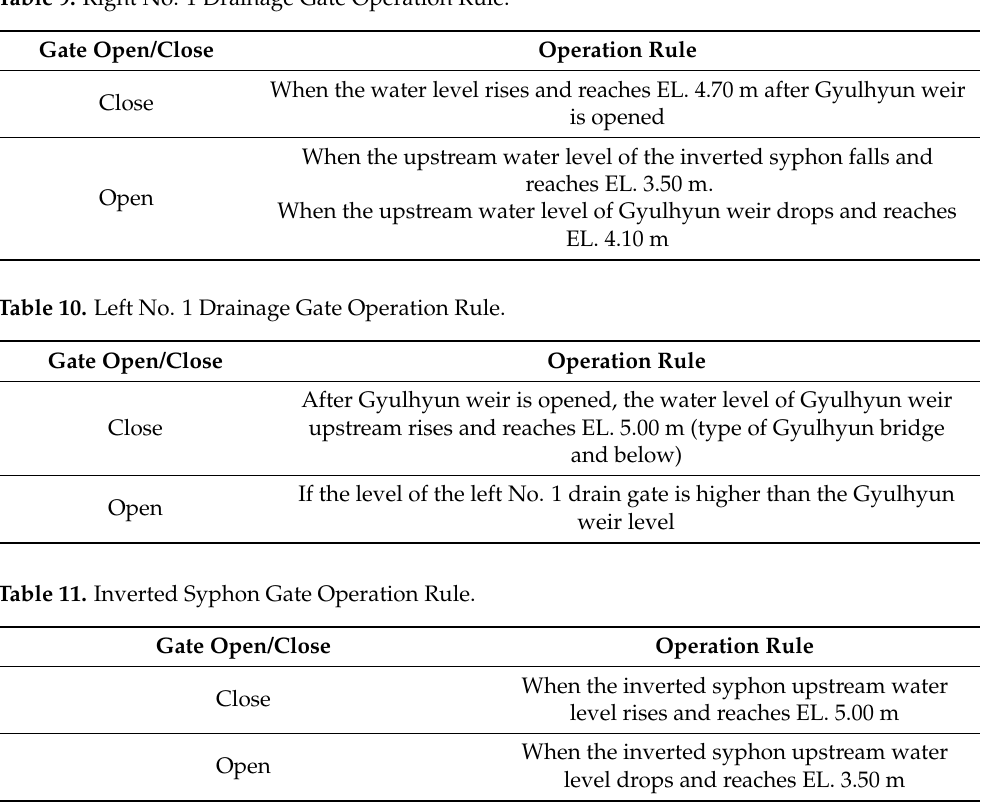
Table 9. Right No. 1 Drainage Gate Operation Rule.